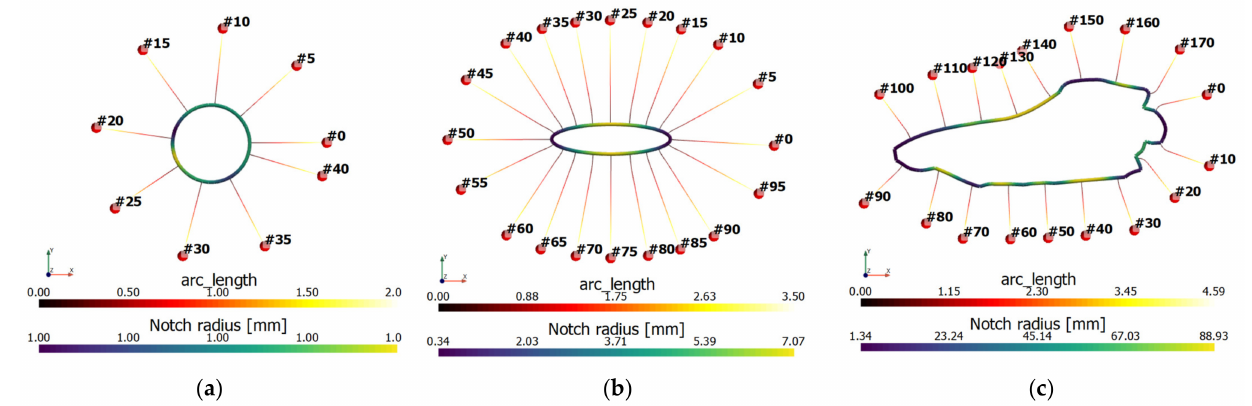
Figure 10. Computed vector paths for three defect geometries: ( a ) Circular hole-in-plate (mesh ‘circle_lin_R1mm_v1’); ( b ) Elliptical hole-in-plate (mesh ‘ellipsis_lin_rot0deg_v1’); and ( c ) Elongated defect (mesh